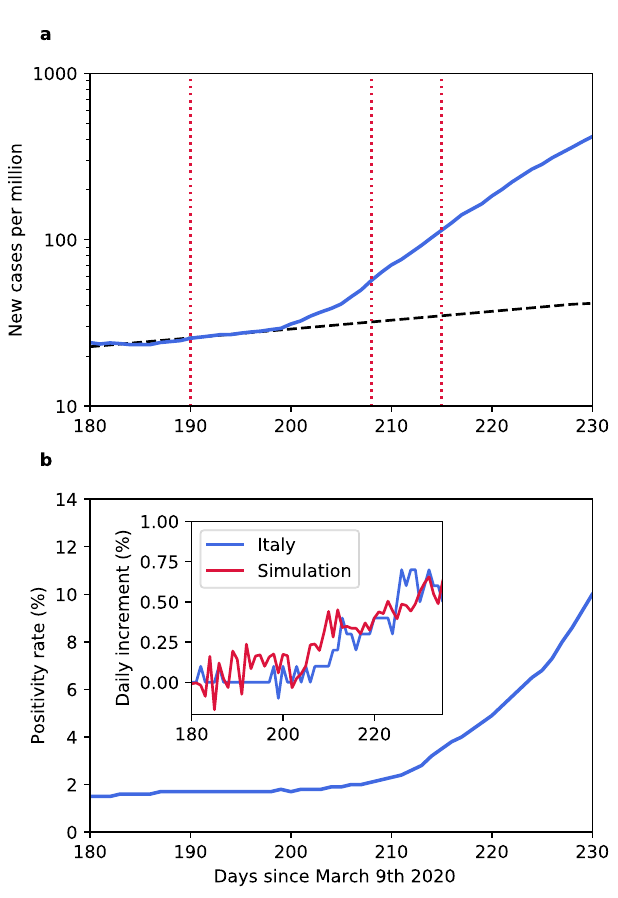
Fig. 3 Period of faster than exponential growth during the second wave of COVID-19 in Italy. a Number of new daily cases per million (logarithmic axis) reported in Italy. The red dotted lines indicate time intervals over which the new cases double, while the black dashed line represents an exponential fi t to the data from day 180 to day 200. After a period of relatively weak exponential growth (days until 200) new cases surge suddenly leading to an intermediate phase of faster than exponential growth similar to what is observed in our simulations (cf. Supplementary given day, during the same time interval. As the number of new cases rapidly increases the contact tracing and testing strategy is put under strain and the positivity rate starts to increase. In the inset we compare the daily increment of positivity rate measured in Italy (blue curve) with the one predicted by a simulation (red curve). In both panels the data represent a 7- days moving average. The simulation parameters are the same ones used to generate the red curve of Fig. 2d.